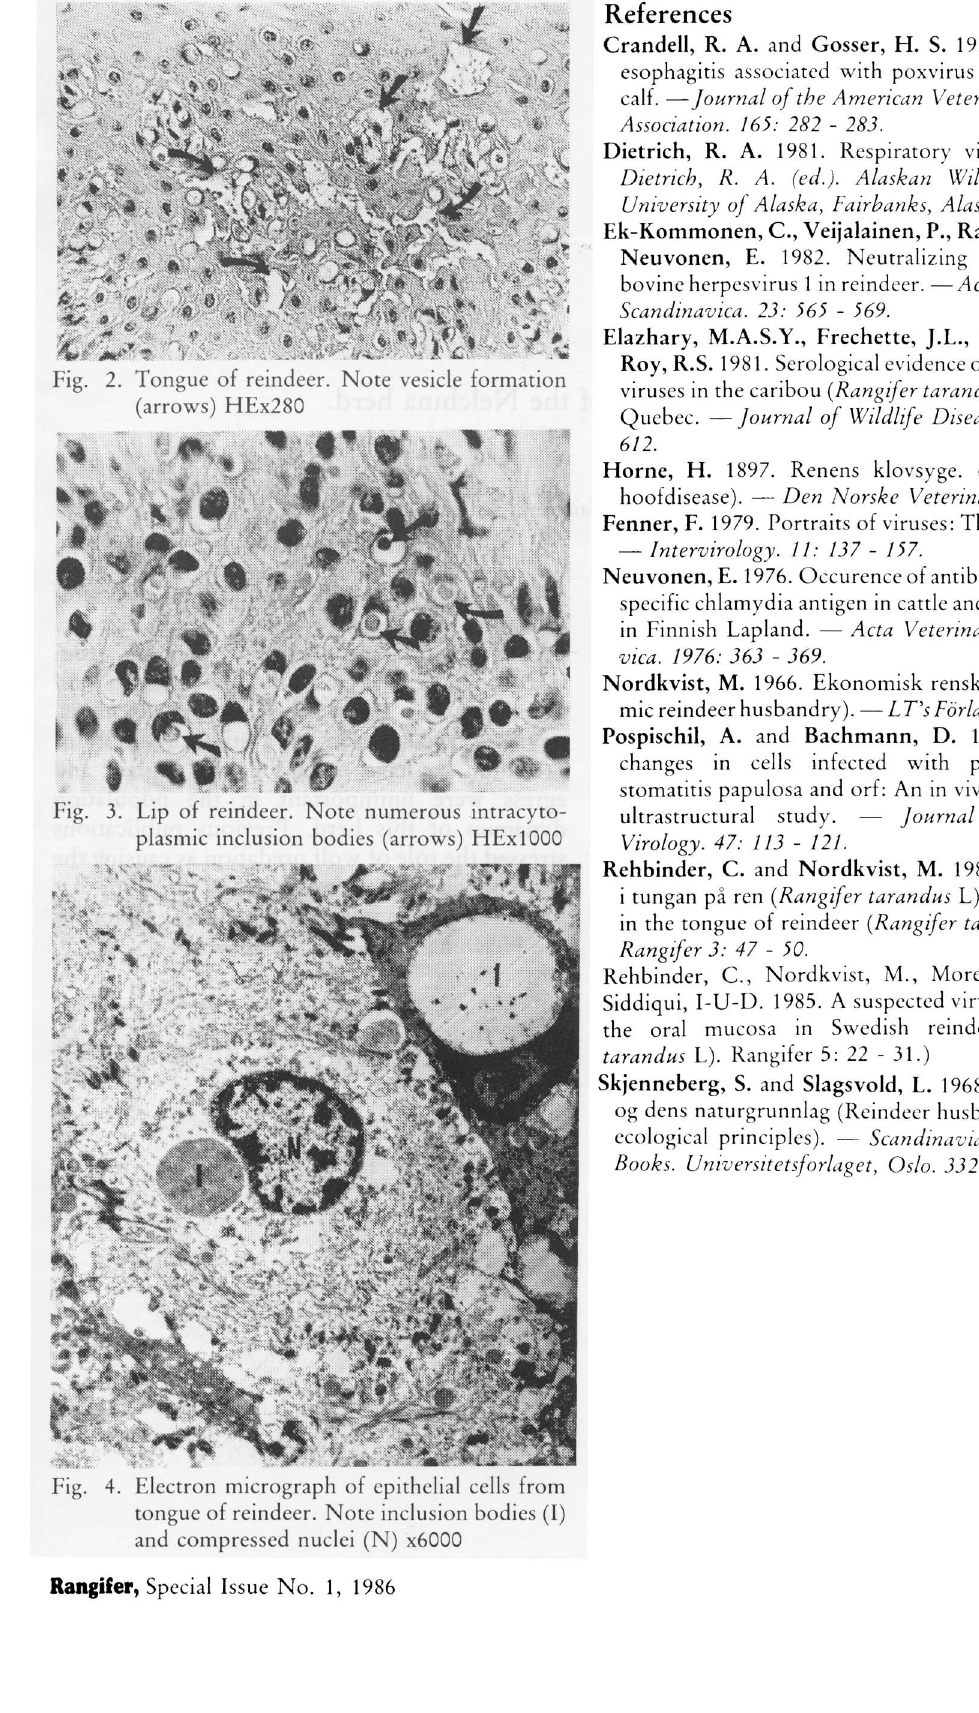
Fig. 4. Electron micrograph of epithelial cells from tongue of reindeer. Note inclusion bodies (I) and compressed nuclei (N)